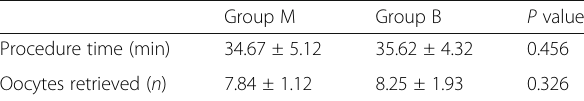
Table 2 Procedure-related variables in both groups (data are presented as mean ± SD)